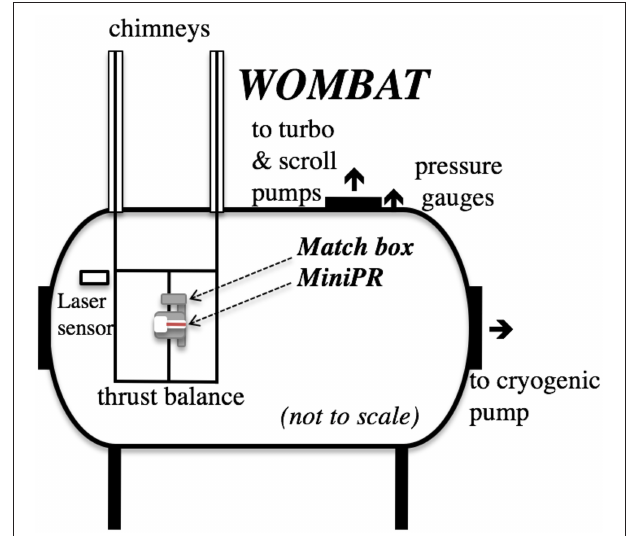
FIGURE 1 | Schematic of the Wombat vacuum chamber showing the MiniPR electrothermal radiofrequency plasma thruster body with Match box mounted on the thrust